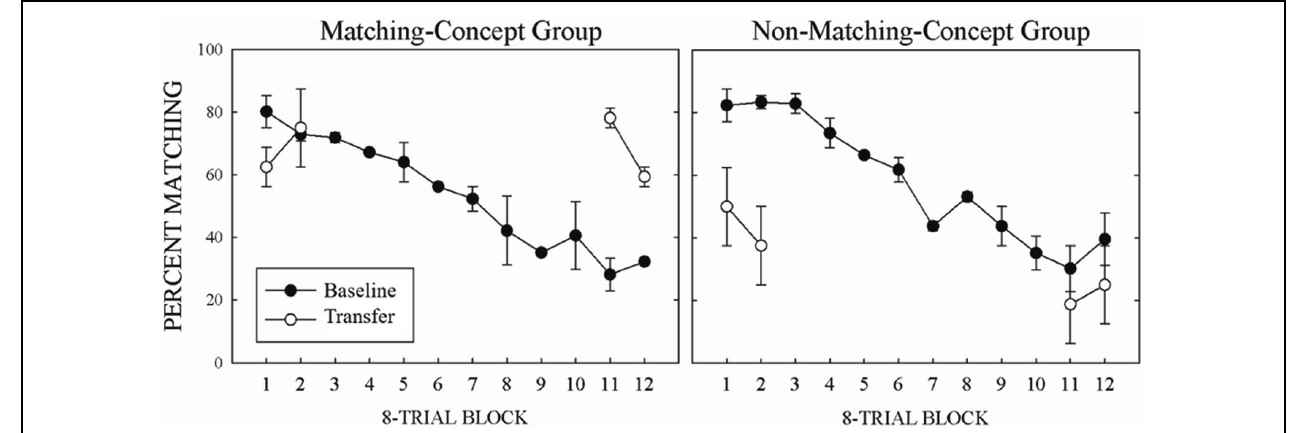
FIGURE 2 | Mean percent correct matching for baseline (filled symbols) and transfer (open symbols) with the MCG in the left panel and the NMCG in the right panel. Error bars represent SEMs.